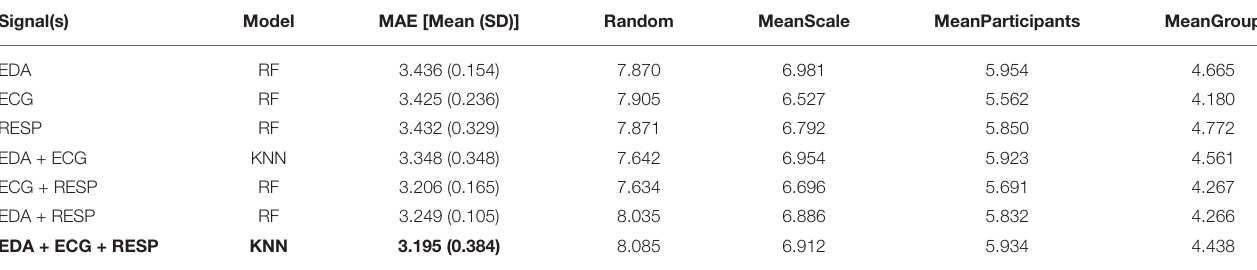
TABLE 8 | Best score achieved by the model to predict task modality for each combination of physiological signals. Signal(s)